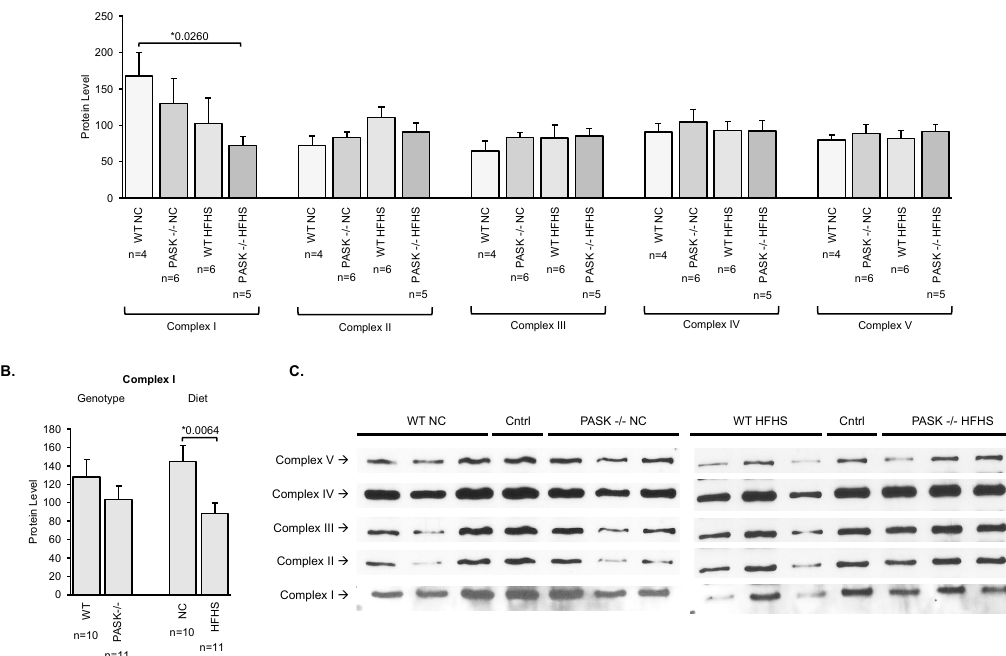
Figure 2. Quantification of 5 electron transport chain complexes using homogenized soleus muscle reveals no significant differences in the PAS kinase-deficient male (PASK − / − ) mice compared to the WT. ( A ) Soleus tissue was homogenized and analyzed by western blot using the OxPhosBlue Native WB Antibody Cocktail (ThermoFisher Scientific, Waltham, MA, USA) containing mouse monoclonal NDUFA9 (complex I), SDHA (complex II), UQCRC2 (complex III, core II), COX IV (complex IV, subunit IV) and ATP5A (complex V alpha subunit) antibodies. Protein concentration was determined before loading using the Pierce Coomassie Plus (Bradford) Assay Reagent (ThermoFisher Scientific, Waltham, MA, USA). The same control sample (cntrl) was loaded on each gel for normalization between gels. ( B ) Plots of one-factor (genotype or diet) analysis of complex I. ( C ) Representative western blots for each complex are shown. Each biological replicate n > 4 was run in duplicate. Error bars represent SEM. Two-factor (genotype and diet) ANOVA was performed using JMP Pro14 software with students t-test performed on significant differences, * p < 0.05 is shown.